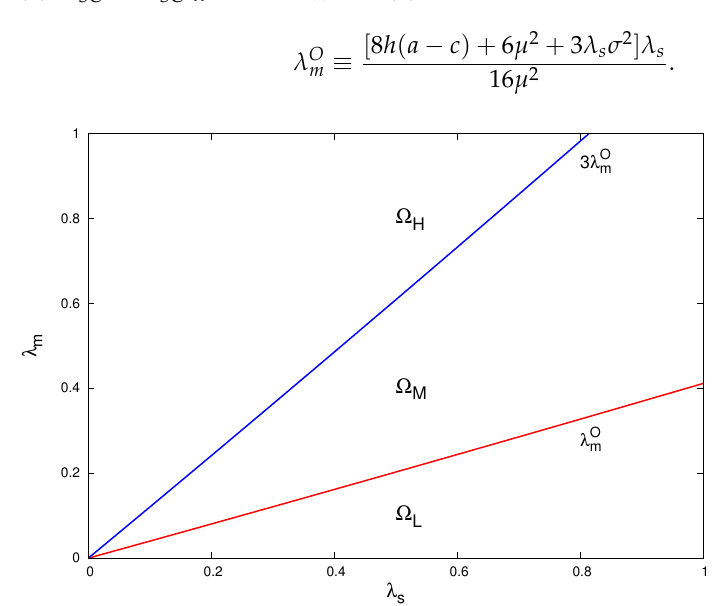
Figure 1. Effect of CEA information accuracies under outsourcing